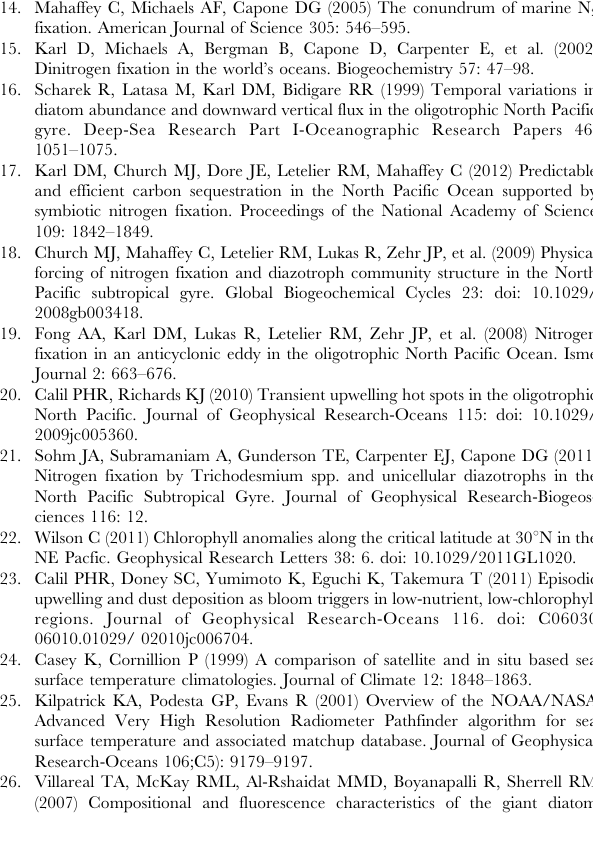
represented stations outlined in red. (TIF) Figure S4 Transect in the subtropical front, 2009 post- bloom. Stations are labeled above the figure. Note x-axis is in longitude, not latitude. A. Temperature ( u C). B. Salinity (PSU) C. Total diatom abundance (cells L 2 1 ) D. R. intracellularis (filaments L 2 1 ). E. Extracted chl a ( m g L 2 1 ). F. . 10 m m chl a ( m g L 2 1 ). G. % . 10 m m chl a. H. Biogenic silica (nmol L 2 1 ). I. Cruise track with